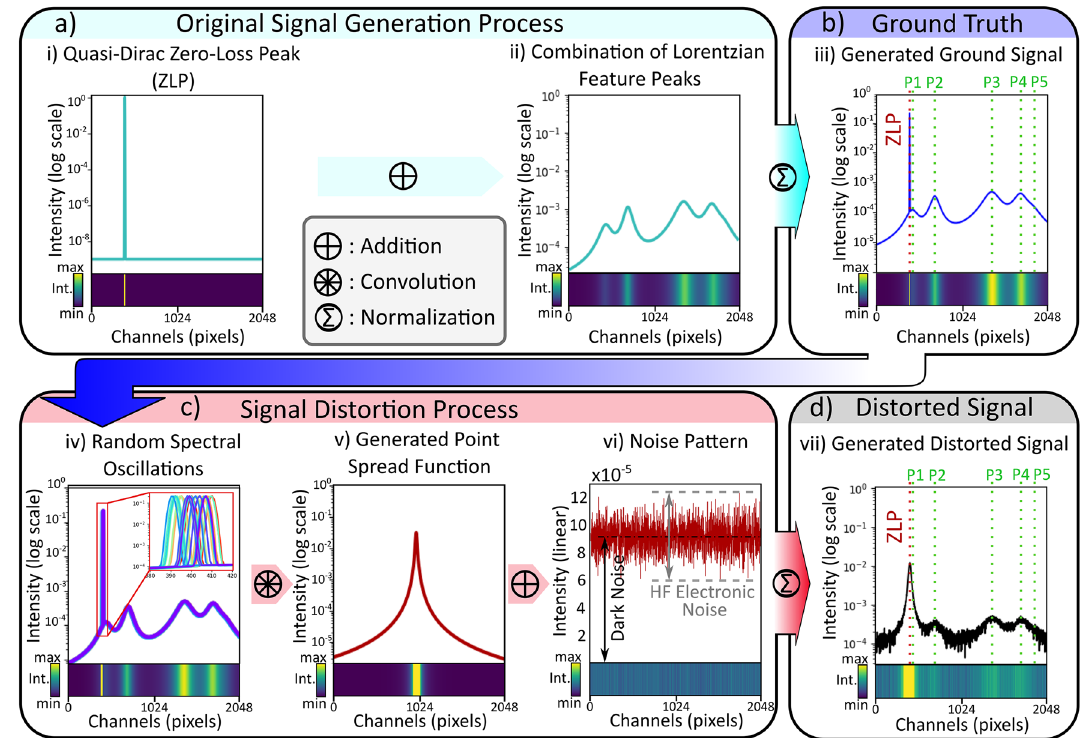
Figure 2. A schematic illustration of data generation pipelines for NZ-EELS generalized-learning. Each signal is also shown using energy resolved heat maps below them for better visualization of the data. ( a ) A demonstration of ground truth generation using a quasi-Dirac function and a combination of Lorentzian peaks. ( b ) The ground truth signal, normalized by the integral of the signal. ( c ) Signal distortion steps including energy jitters of the beam, optical transfer function broadening, and high frequency noise. ( d ) The distorted signal, normalized by integral of the